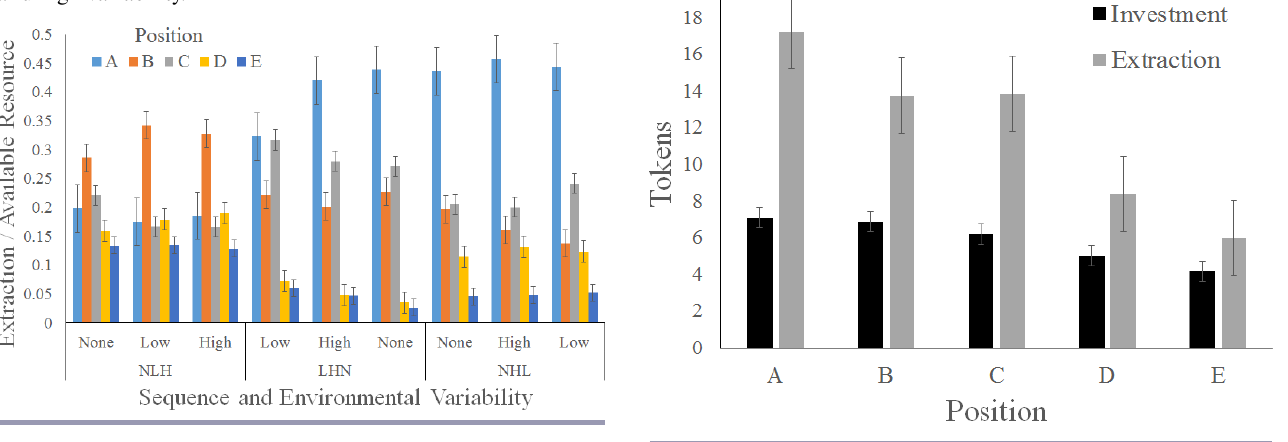
Fig. 3 . Tokens extracted as fraction of water availability per sequence and variability level. LHN, low, high, and no variability; NHL, no, high, and low variability; NLH, no, low, and high variability.